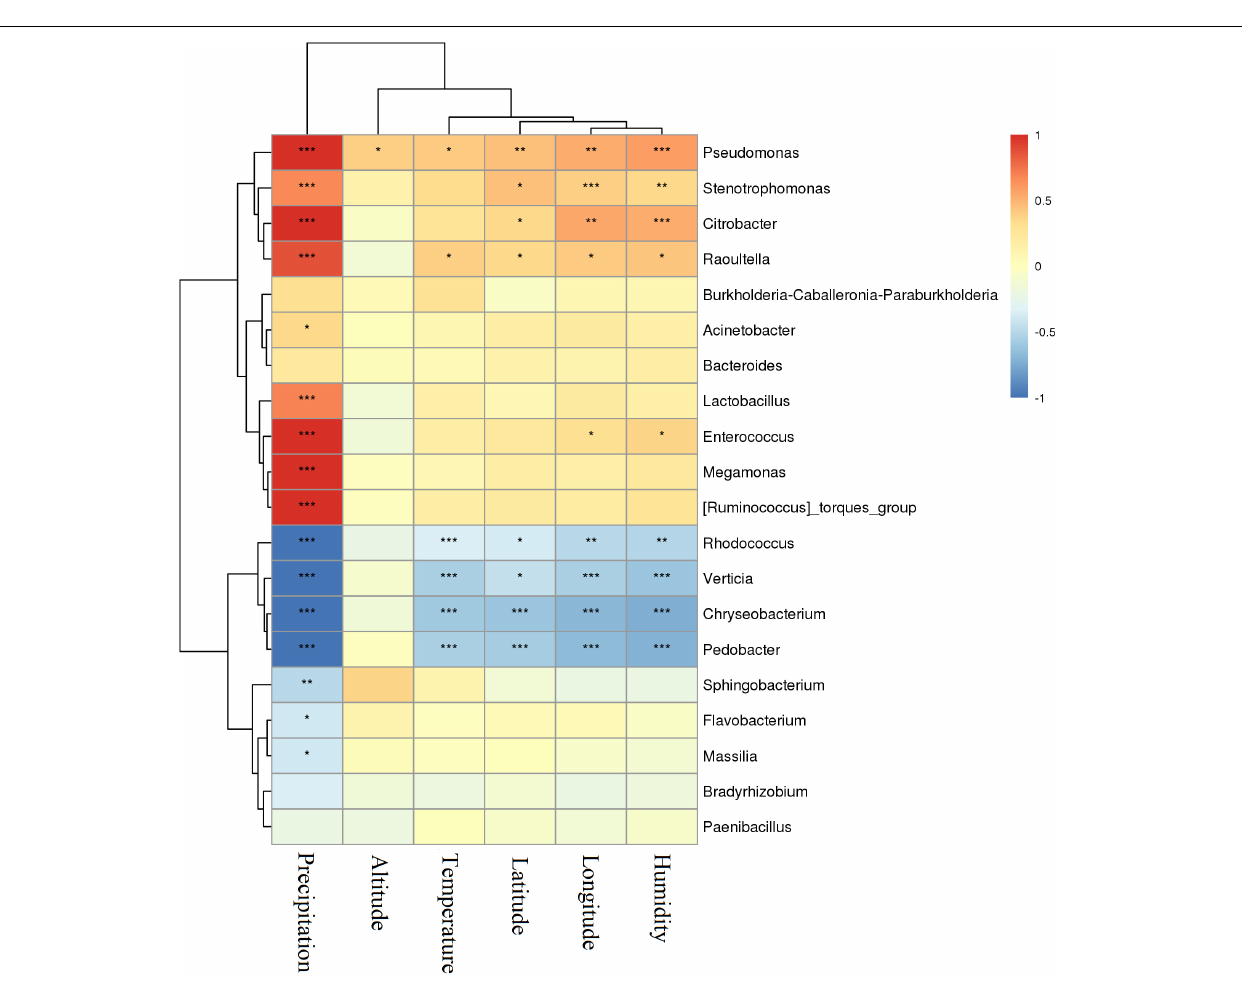
different varieties of P. sinese was quite different, so the characteristics of silage microbial community were also